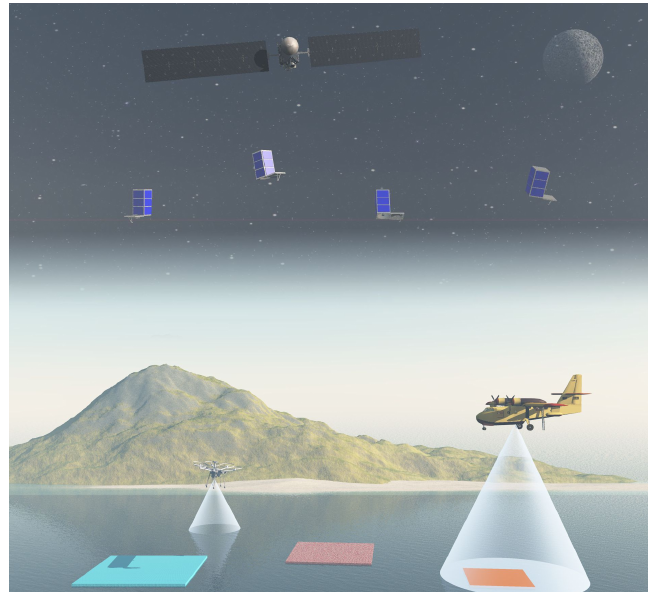
Figure 1. Conceptual framework for a remote marine litter detection